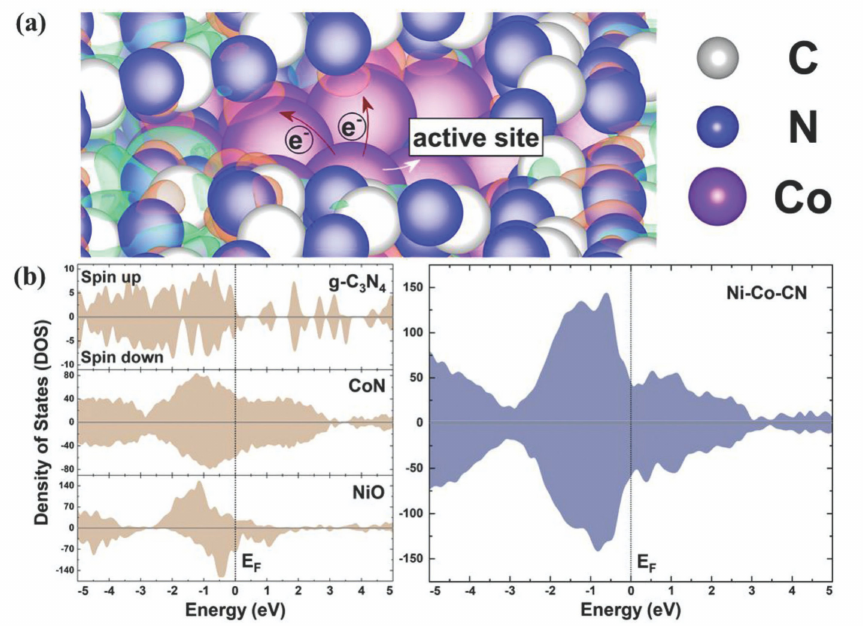
Figure 12. ( a ) Charge density difference of the Ni–Co–CN surface. Electron excess and deficiency are represented as red and green, respectively. The iso-surface was set as 0.0035 e Å − 1 . ( b ) Density of states (DOS) profiles of the partial ( left ) and ensemble ( right ) Ni–Co–CN species. Reproduced from Ref. [197] with permission from the Royal Society of Chemistry. Table 5. Selection-comparison of carbon–metal nitrides and phosphides electrocatalysts. KOH Electrolyte Overpotential at Concentration 10 mA cm − 2